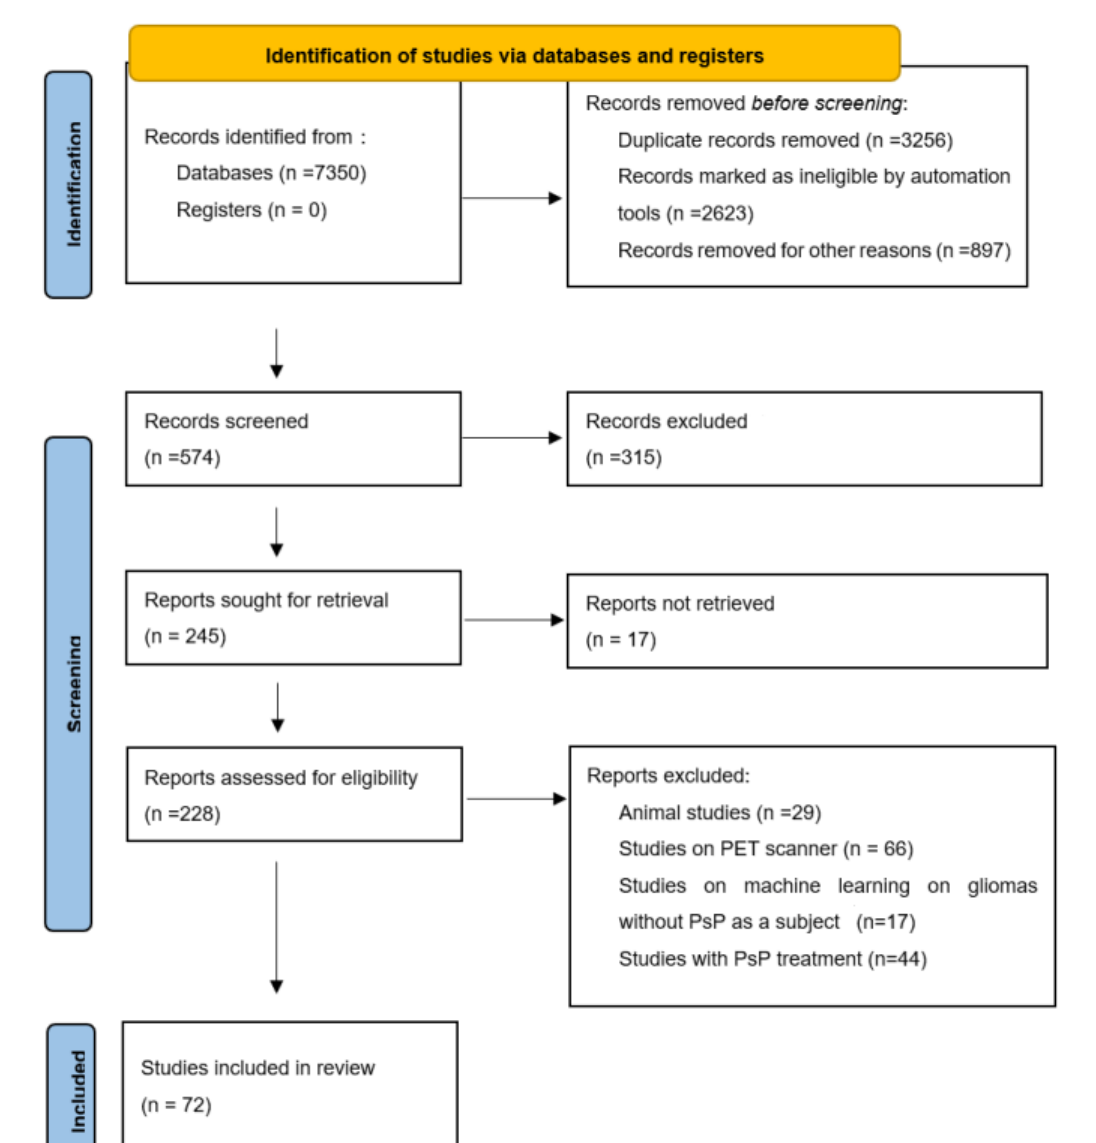
Figure 1. Study flow chart from PRISMA flow diagram 2020 statement. PsP = pseudoprogression, PET = positron emission tomography, PRISMA = preferred reporting items for systematic reviews and meta-analyses.